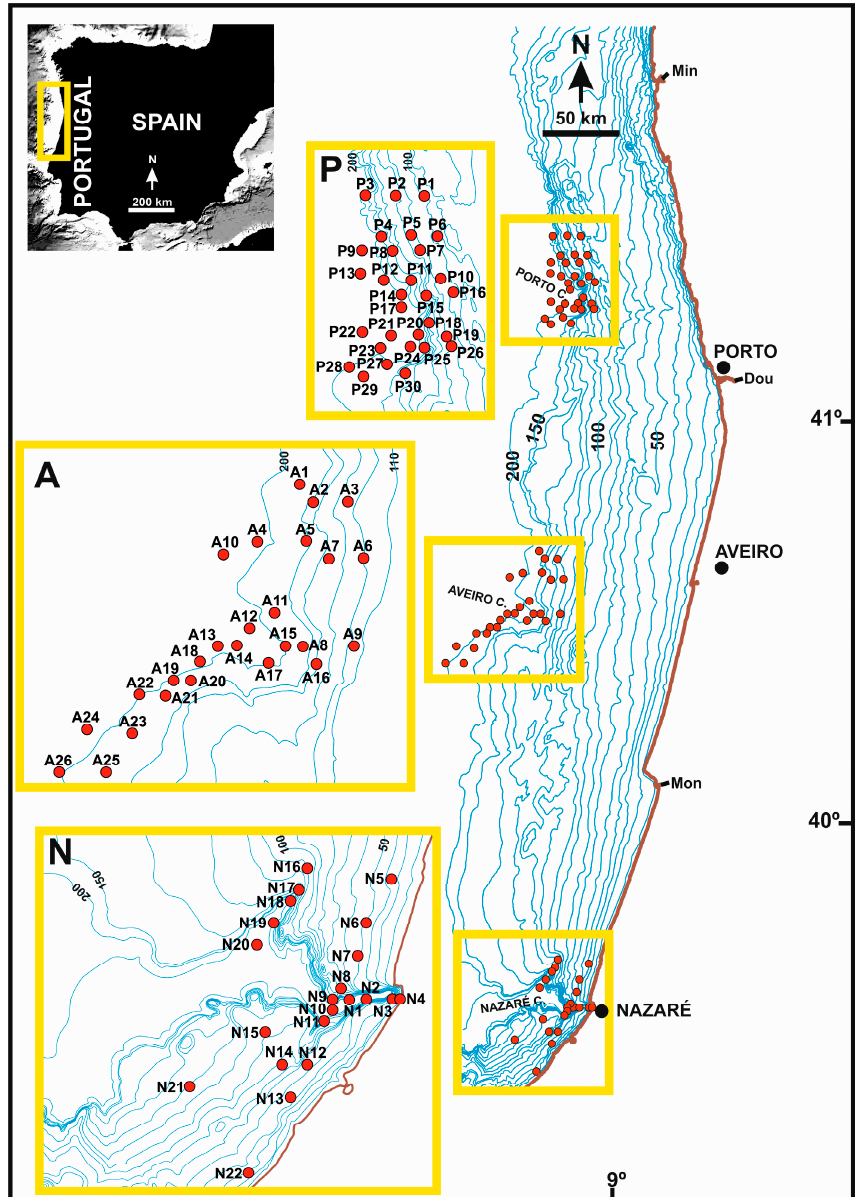
Figure 1. Location of the samples according the three studies areas: Porto (P), Aveiro (A), and Nazaré (N) canyon head areas. Min, Minho River; Dou, Douro River; Mon, Mondego River. Bathymetric contour lines are in meters.